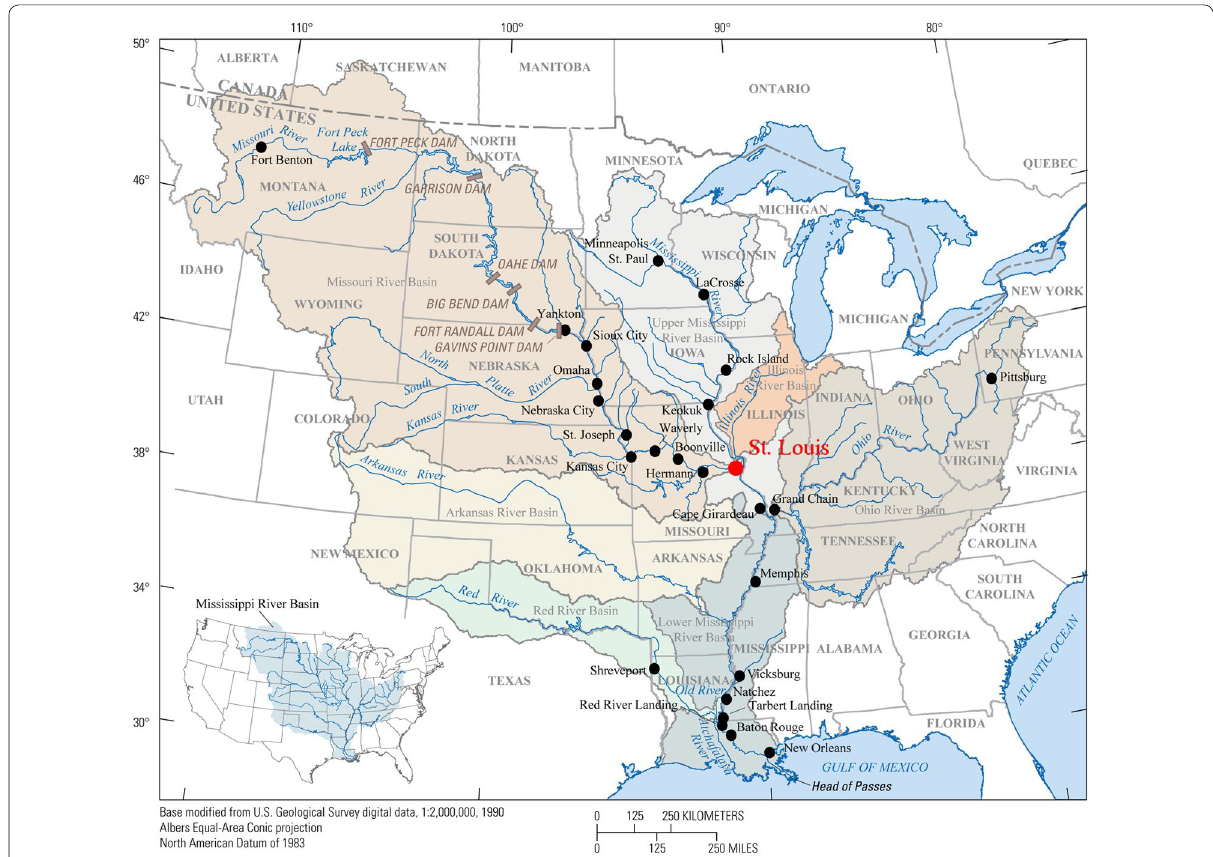
Fig. 3 The Mississippi River Basin and location of St. Louis, Missouri, USA (adapted from Alexander et al.